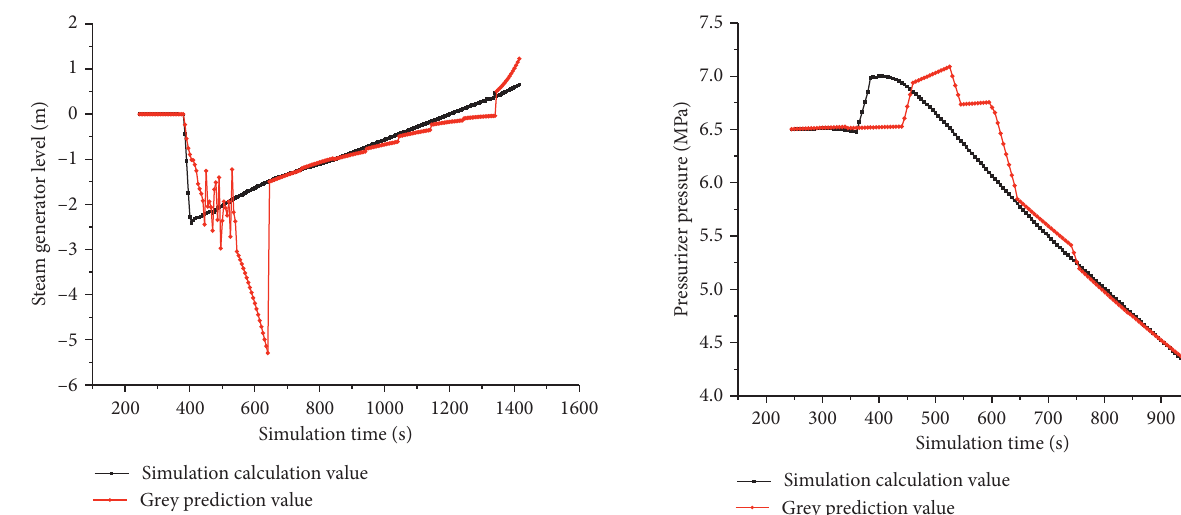
Figure 12: The comparison of the actual and predicted data of the steam generator pressure.